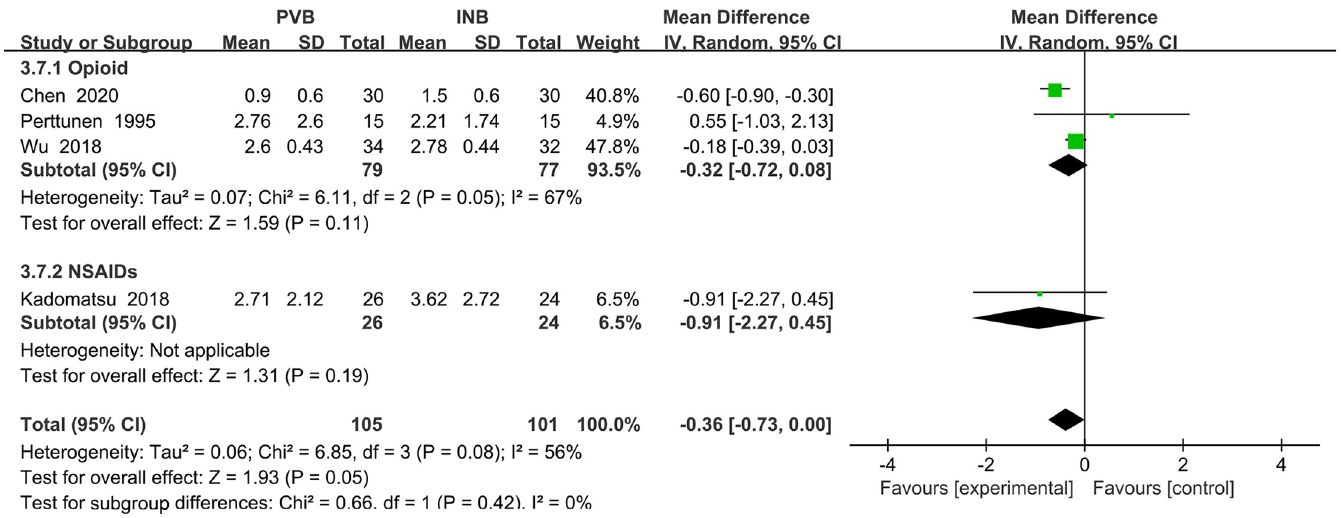
Fig 13. Subgroup analysis of comparison: Opioids drug VS NSAIDs. Outcome: VAS at rest at the first 24 h.